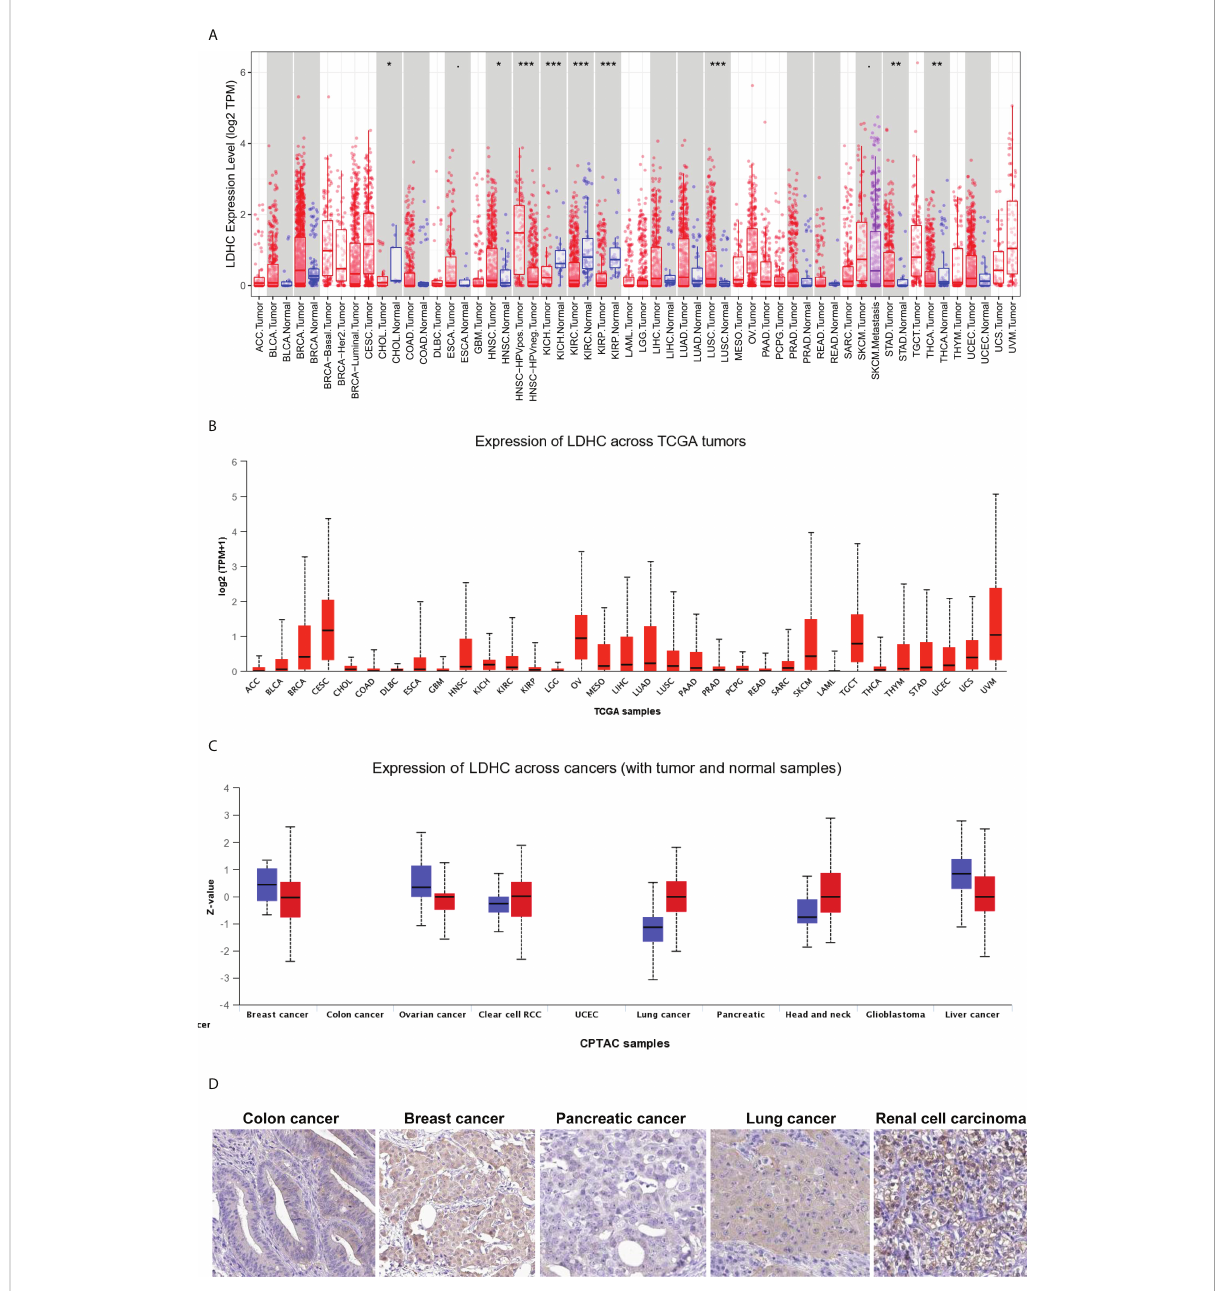
FIGURE 2 Pan-cancer expression of LDHC/LDH-C4 in public databases. Pan-cancer LDHC expression in (A) TIMER and (B) UALCAN databases. (C) Pan- cancer expression analysis of LDH-C4 in the UALCAN database. (D) IHC analysis of pan-cancer LDH-C4 using the HPA database. ACC, adrenocortical carcinoma; BLCA, bladder urothelial carcinoma; BRCA, breast invasive carcinoma; CESC, cervical squamous cell carcinoma and endocervical adenocarcinoma; CHOL, cholangio carcinoma; COAD, colon adenocarcinoma; DLBC, lymphoid neoplasm diffuse large B-cell lymphoma; ESCA, esophageal carcinoma; GBM, glioblastoma multiforme; HNSCC, head and neck squamous cell carcinoma; KICH, kidney chromophobe; KIRC, kidney renal clear cell carcinoma; KIRP, kidney renal papillary cell carcinoma; LAML, acute myeloid leukemia; LGG, brain lower-grade glioma; LIHC, liver hepatocellular carcinoma; LUCA, lung cancer; LUAD, lung adenocarcinoma; LUSC, lung squamous cell carcinoma; MESO, mesothelioma; OV, ovarian serous cystadenocarcinoma; PAAD, pancreatic adenocarcinoma; PCPG, pheochromocytoma and paraganglioma; PRAD, prostate adenocarcinoma; READ, rectum adenocarcinoma; RCC, renal cell carcinoma; SARC, sarcoma; SKCM, skin cutaneous melanoma; STAD, stomach adenocarcinoma; TGCT, testicular germ cell tumors; THCA, thyroid carcinoma; THYM, thymoma; UCEC, uterine corpus endometrial carcinoma; UCS, uterine carcinosarcoma; UVM, uveal melanoma. * P < 0.05, ** P < 0.01, and *** P <